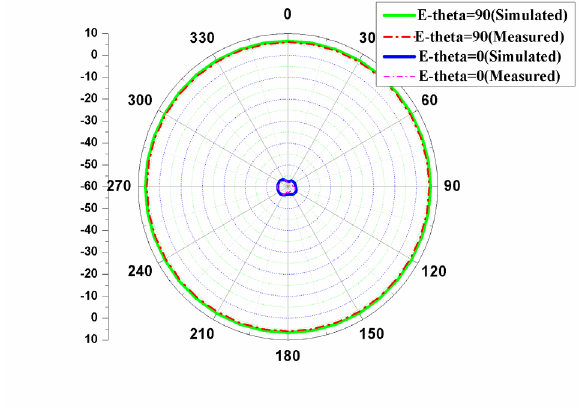
Fig. 9. 2D azimuth pattern at the resonant frequency of 5.37 GHz.